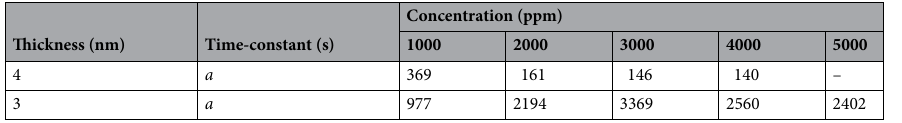
Table 2. Fitted values of time constant a obtained at different concentrations of H 2 gas for ultra-thin Pd films of thickness 4 nm and 3 nm.